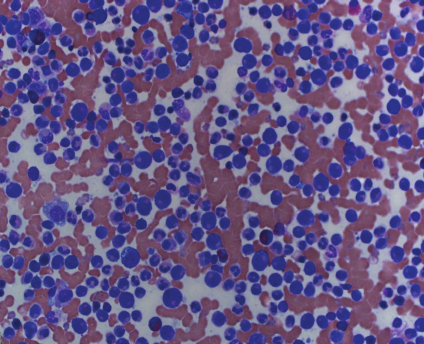
Figure 2: Bone marrow aspiration reveals predominance of myeloid lineage.